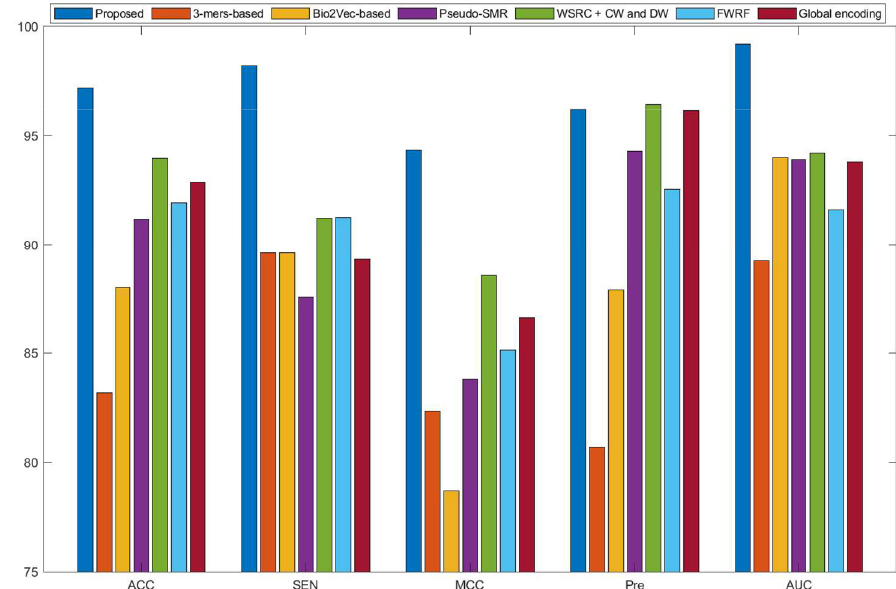
Figure 3. Comparison results of different methods on the H. pylori data set.